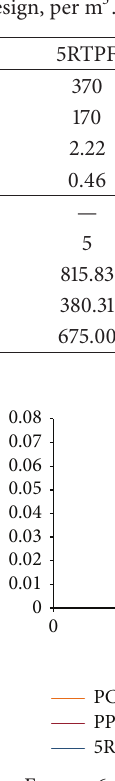
Figure 6: Average autogenous shrinkage for all